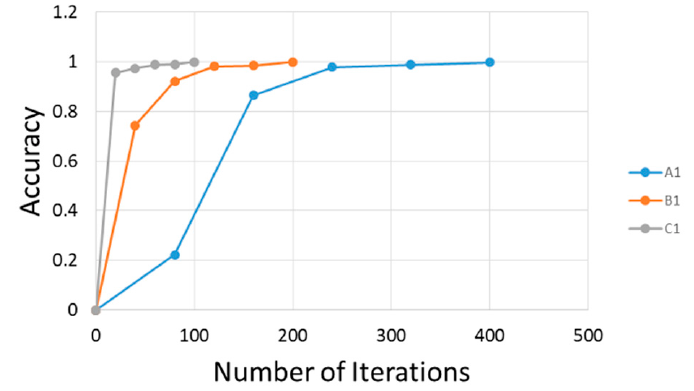
Figure 6. The accuracy of the initial weight table.